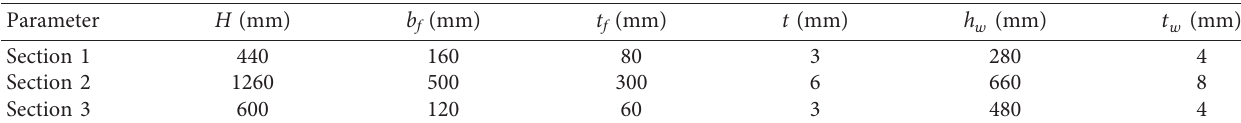
Table 9: The sizes of the three